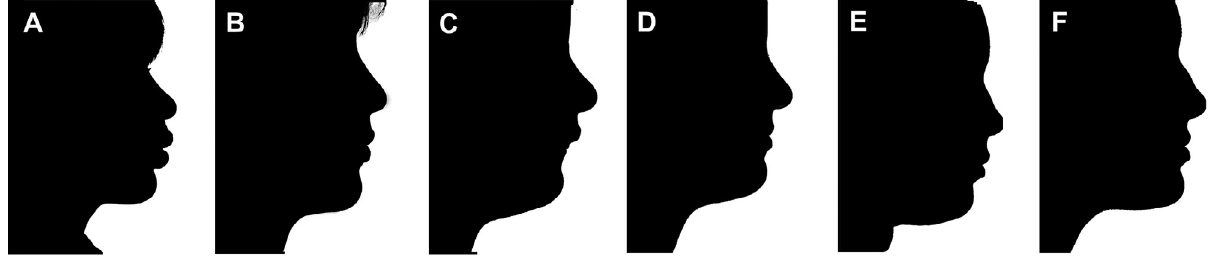
Figure 1. Silhouettes of representative patients whose esthetic changes most closely matched the average group changes: A) pro- trusive maxillas, before treatment and B) after treatment; C) normally positioned maxillas, before treatment and D) after treatment; E) retrusive maxillas, before treatment and F) after